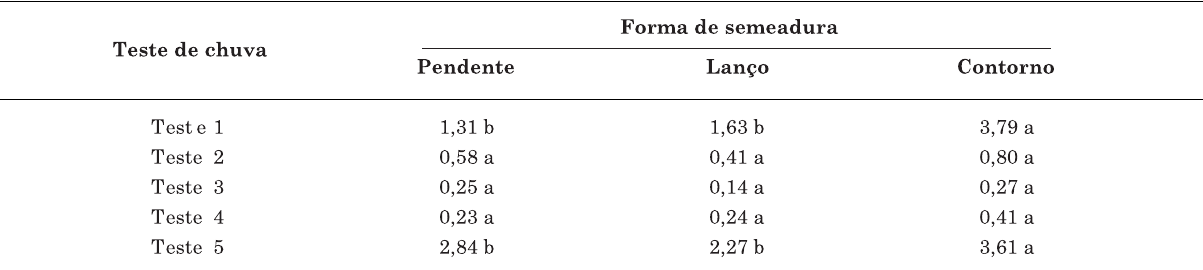
Figura 2. Relação entre o teor de N-NO enxurrada e quantidade de chuva acumulada (natural e simulada) durante o ciclo das culturas de aveia e ervilhaca (média das formas de semeadura e das